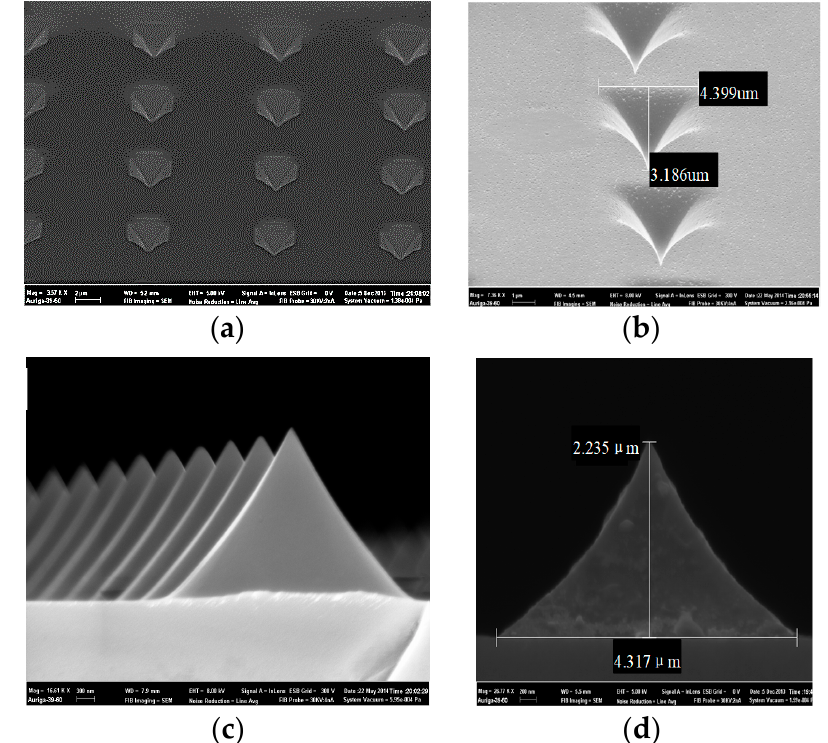
Figure 8. Scanning electron microscopy (SEM) of the cathode tip array. ( a ) Array front view, ( b ) partial front view, ( c ) array side view, and ( d ) partial side view.